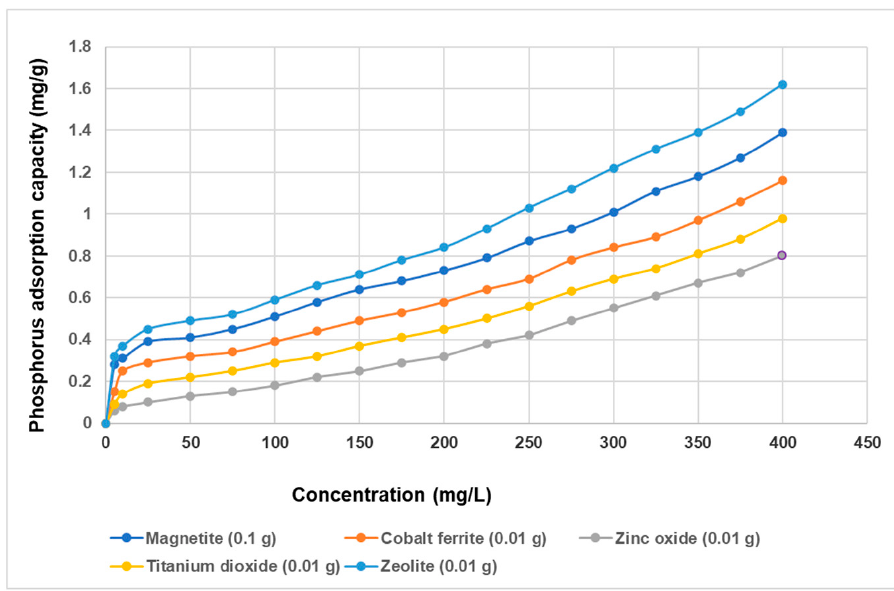
Figure 12. Relationship between initial concentration and adsorbents’ phosphorus adsorption ca-